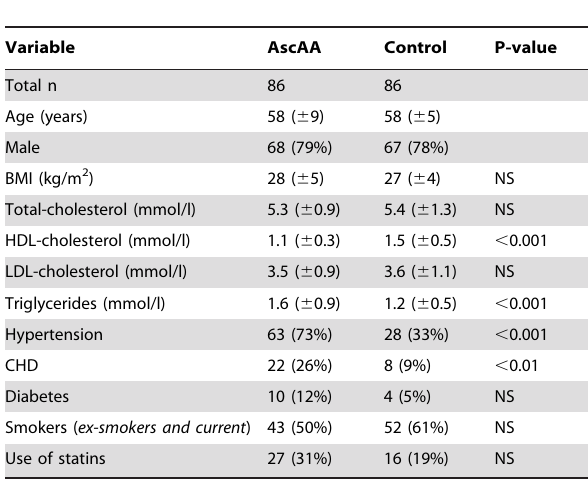
Table 1. Demographic characteristics of the study groups in the relative telomere length